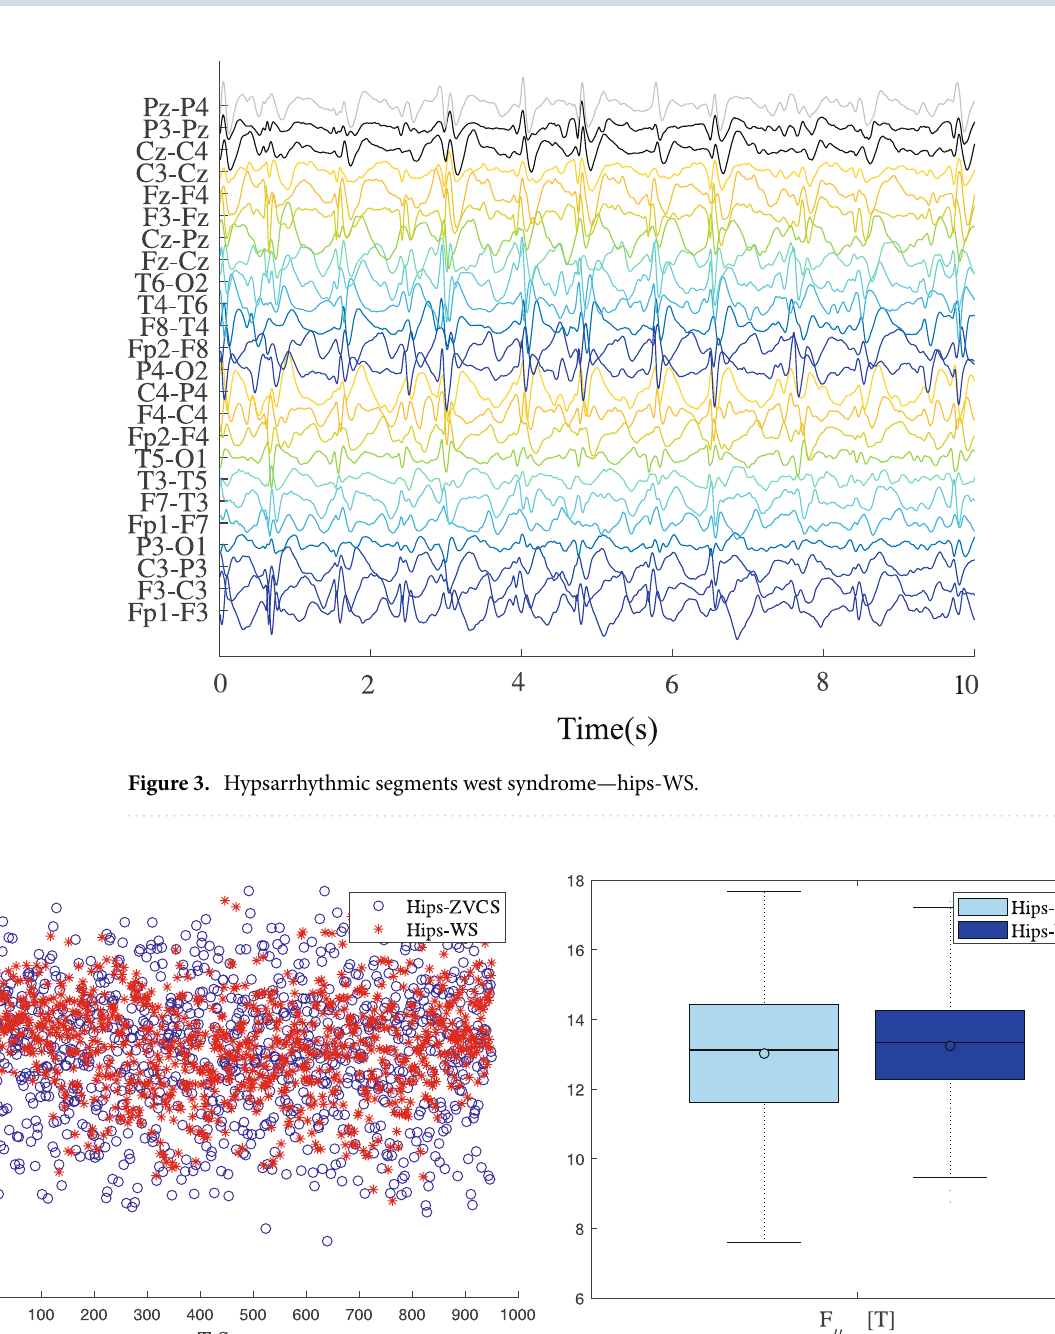
Figure 4. Distribution of the the joint time-frequency moment indices F µ